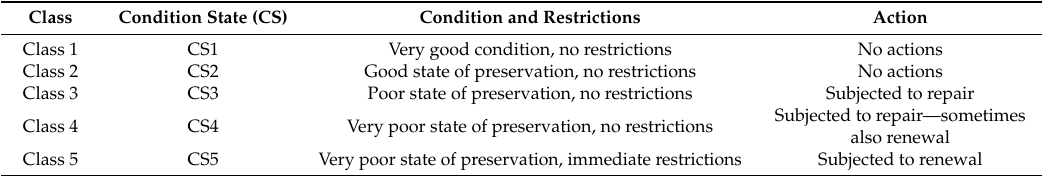
Table 10. Condition rating system used by the ÖBB, with assigned condition, restriction, and action for each class